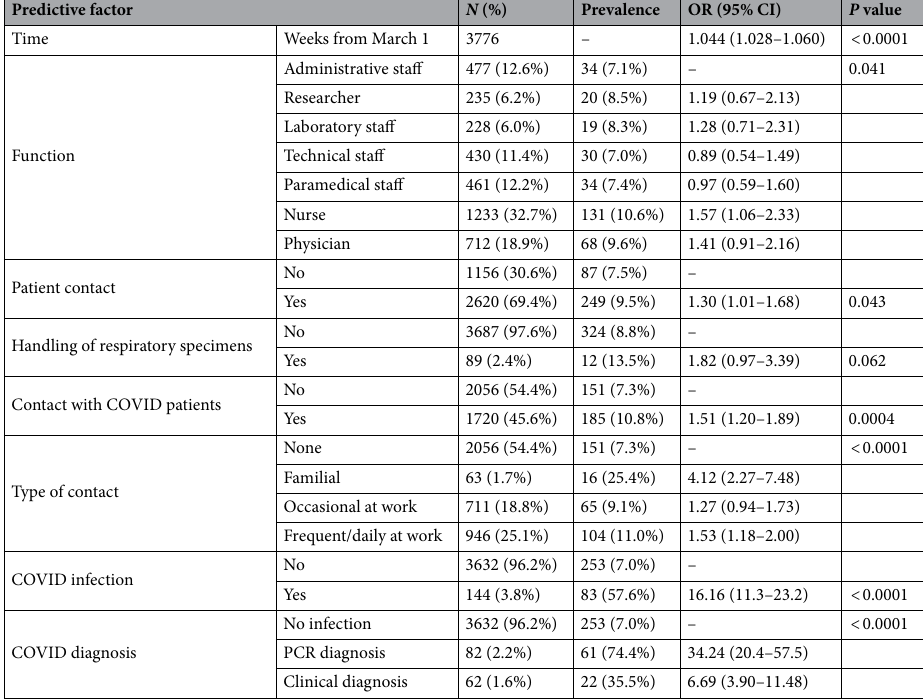
Table 2. Predictors of SARS-Cov-2 positive serology (IgG DiaSorin) in phase 1: direct exposure. OR = odds ratio of univariate logistic regression models adjusted for time between March 1 and testing; CI = confidence